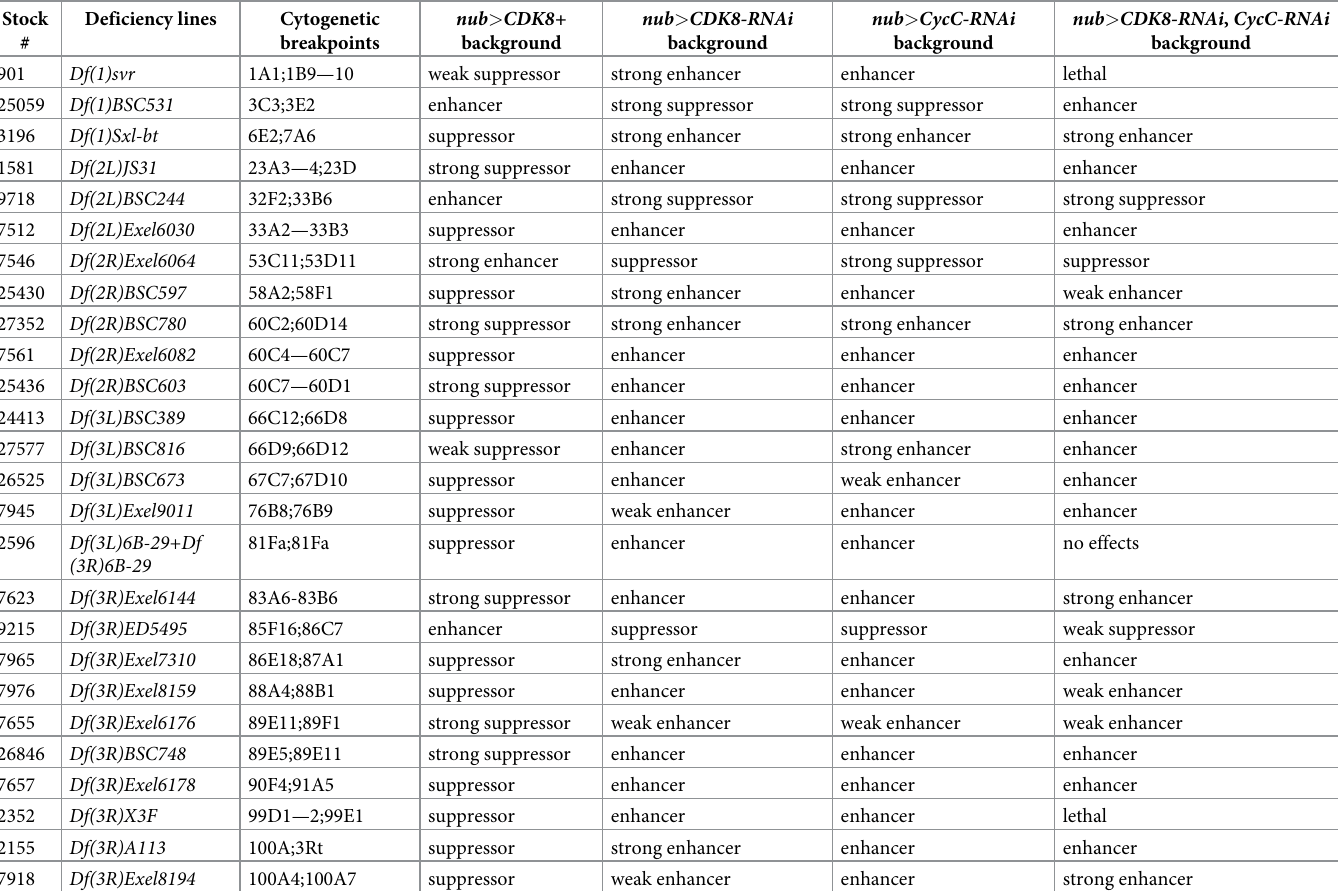
Table 1. Deficiency lines that dominantly modify the CDK8- or CycC-specific